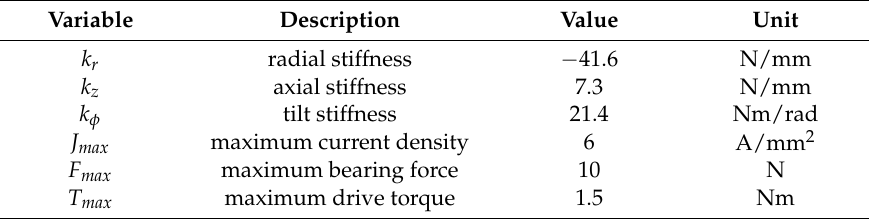
Table 3. Main electromagnetic parameters of the prototype